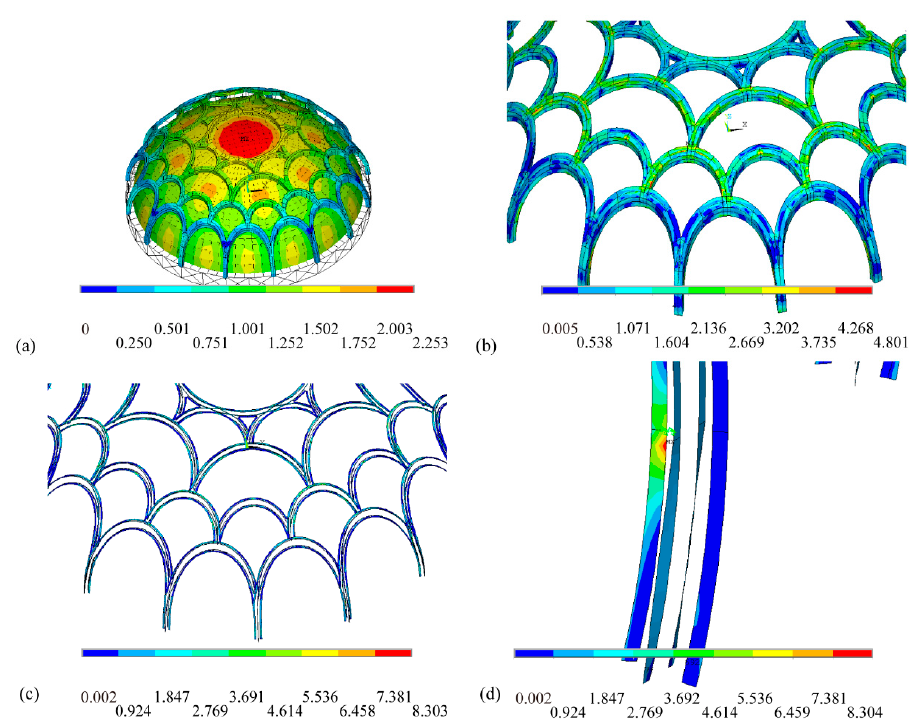
Figure 2. ( a ) Displacement and stress distributions of ( b ) web, ( c ) longitudinal stiffening rib, and ( d ) diaphragm under applied 1 P load. ( d ) diaphragm under applied 1 P